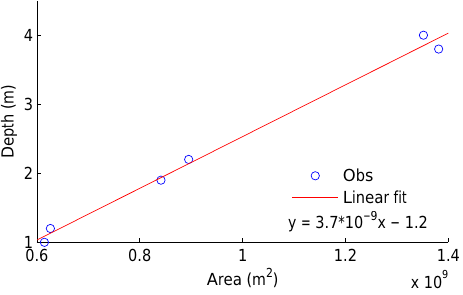
Figure 5. Relationship between measured depth of the middle Ma- hakam lakes and area of open water inundation from PALSAR im-